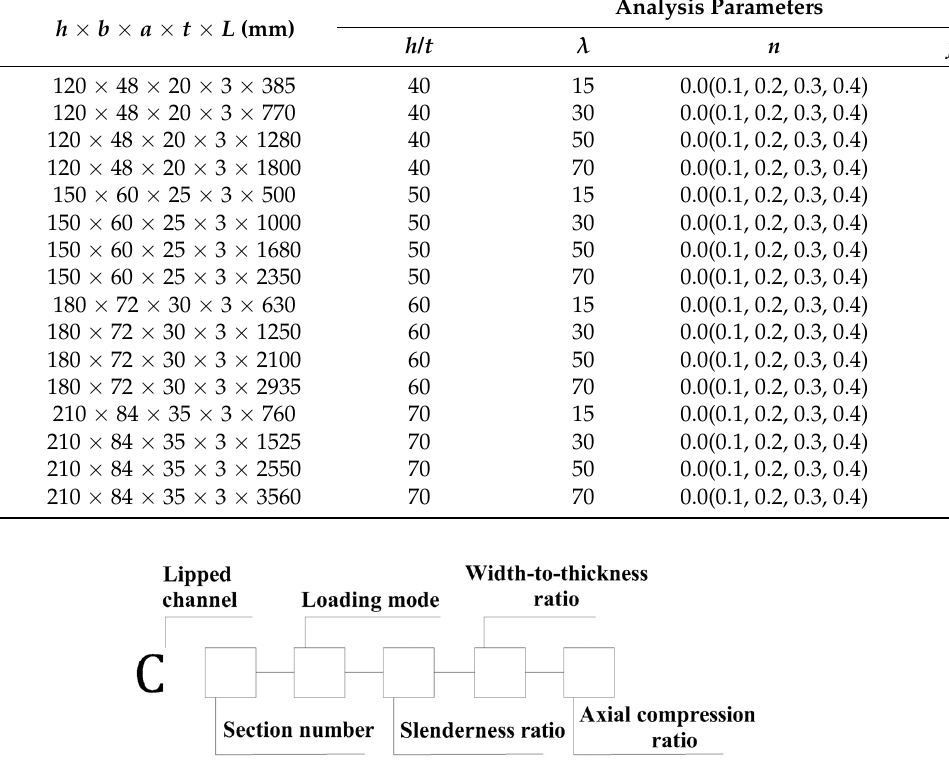
Figure 6. Notation of lipped channel section.